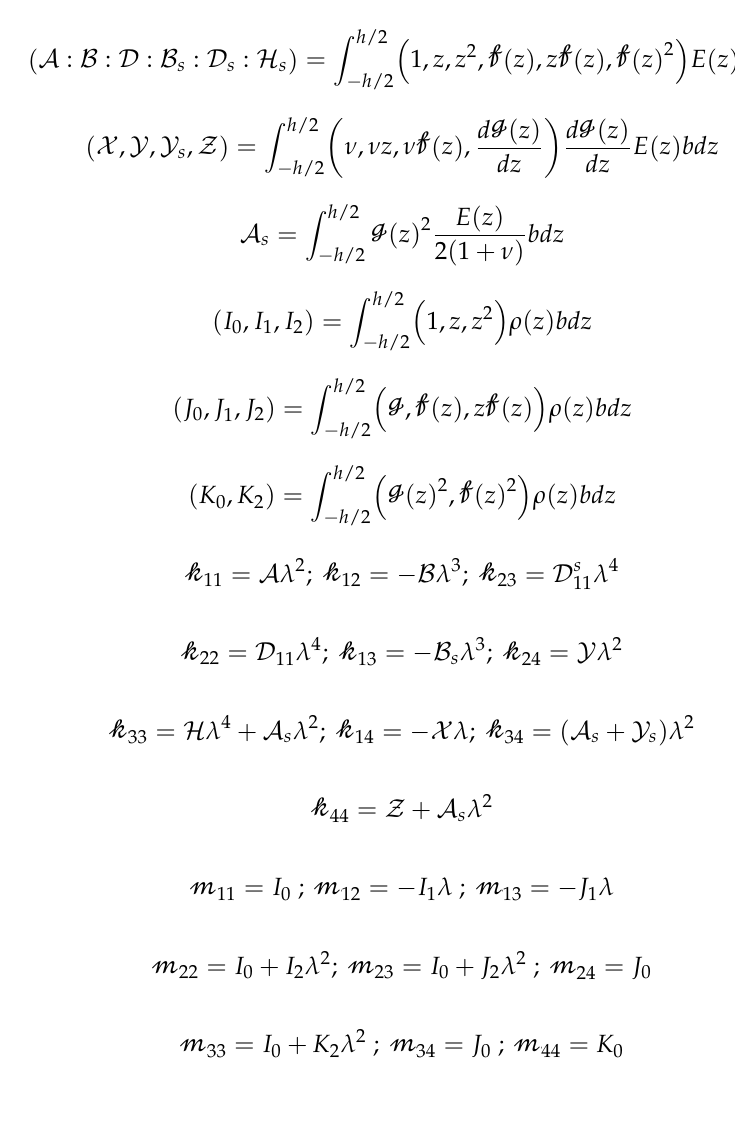
Table 1. Material characteristics of 𝐴𝑙 (cid:2870) 𝑂 (cid:2871) and 𝐴𝑙 [38].